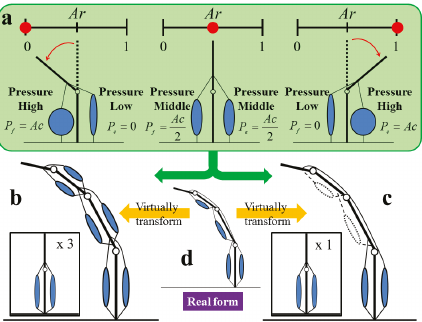
Figure 2: Muscle coordination and two types of virtual antagonistic muscle structures. (a) Principle of the muscle coordination using the antagonistic muscle ratio Ar and the antagonistic muscle activity Ac . When Ar is 0 (left picture), the pressure for the fl exor is high ( P f = Ac ) and the extensor is low ( P e = 0 ). When Ar is 0.5 (middle picture), the pressure for the fl exor and the extensor is identical ( P f = P e = Ac/2 ). When Ar is 1 (right picture), the pressure for the = 0 ) and the extensor is high ( P = Ac ). Therefore, fl exor is low ( P f e the pressures of the extensor and the fl exor are determined by searching for the normalized variable Ar ∈ 0, 1 . (b) One of the virtual antagonistic structures. Two muscles are added virtually to the musculoskeletal system (shown in (d)) to form a symmetrically antagonistic arrangement on the intermediate phalange and the proximal phalange. Therefore, the virtual antagonistic structure has three simple antagonistic muscle structures (inset picture in (b)). (c) The other virtual antagonistic muscle structure. Two muscles on the intermediate phalange and the proximal phalange are decreased virtually from the musculoskeletal robot (shown in (d)), and the muscles are symmetrically arranged on the metacarpal. Therefore, the virtual antagonistic structure has one simple antagonistic muscle structure (inset picture in (c)). (d) The real form of the musculoskeletal robot that is controlled. The value of Ar (shown in (a)) is applied to the virtual antagonistic structure (shown in (b) or (c)) virtually transformed from the musculoskeletal robot (shown in